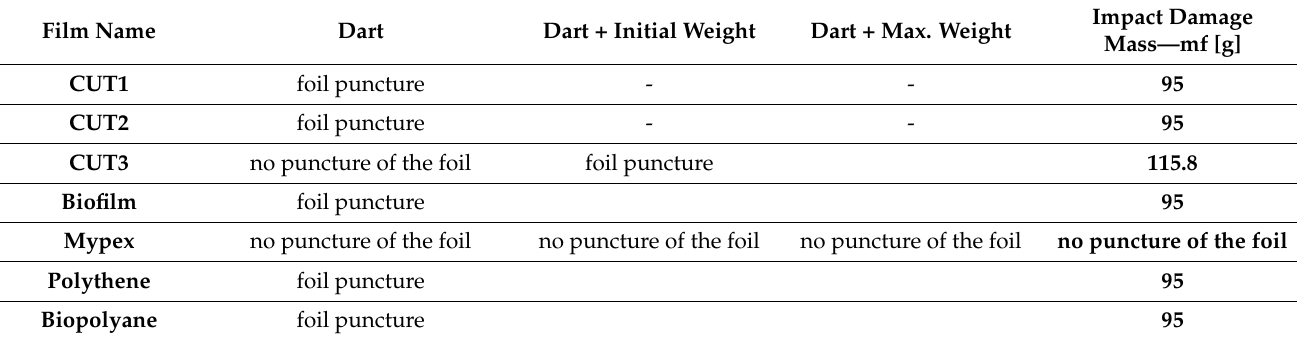
Table 3. Results of determination of impact resistance by the free-falling dart